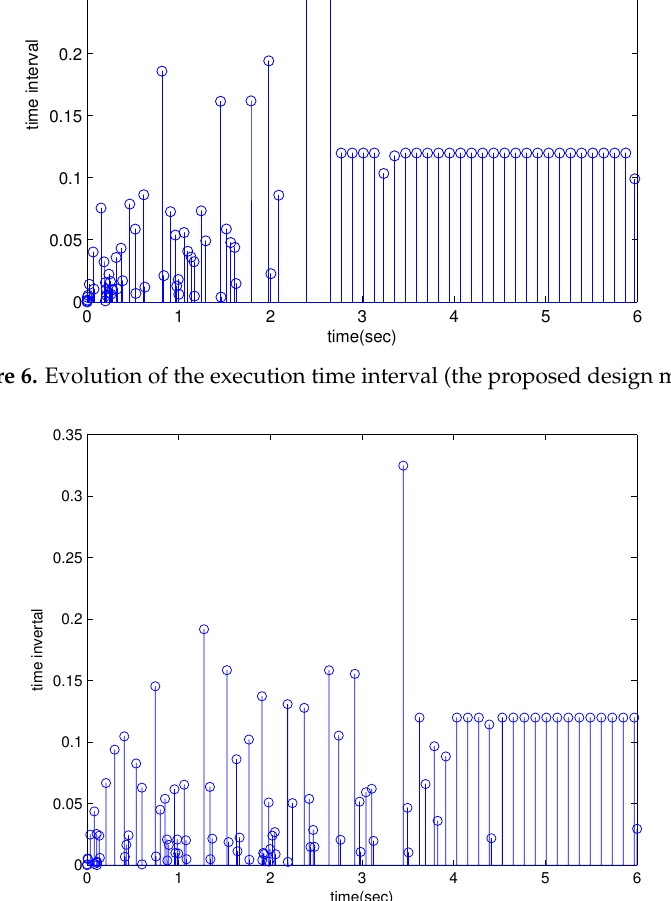
Figure 7. Evolution of the execution time interval (the memoryless design